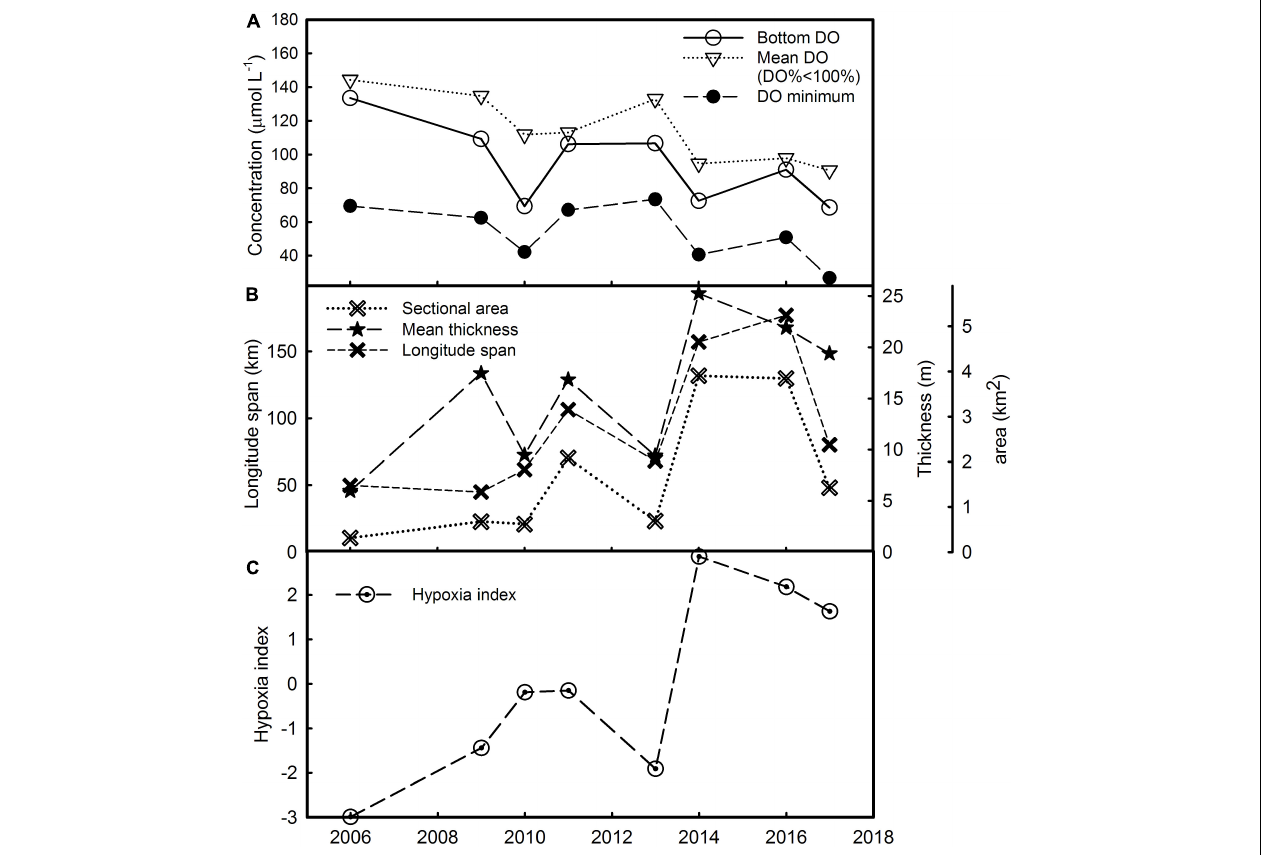
FIGURE 2 | Observable properties of hypoxia including (A) bottom DO, mean DO concentration when DO < 100% and DO minimum, and (B) sectional area, mean thickness and longitude span used to derive (C) the hypoxia index (HI) during 8 years.